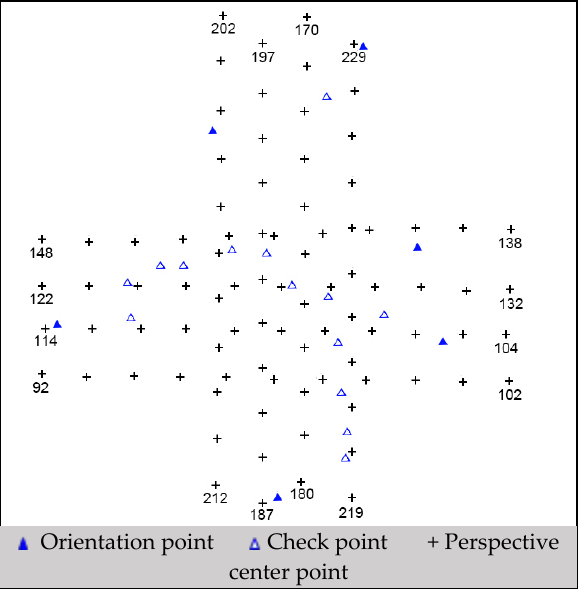
Figure 1. The Distribution of the Beijing UAV